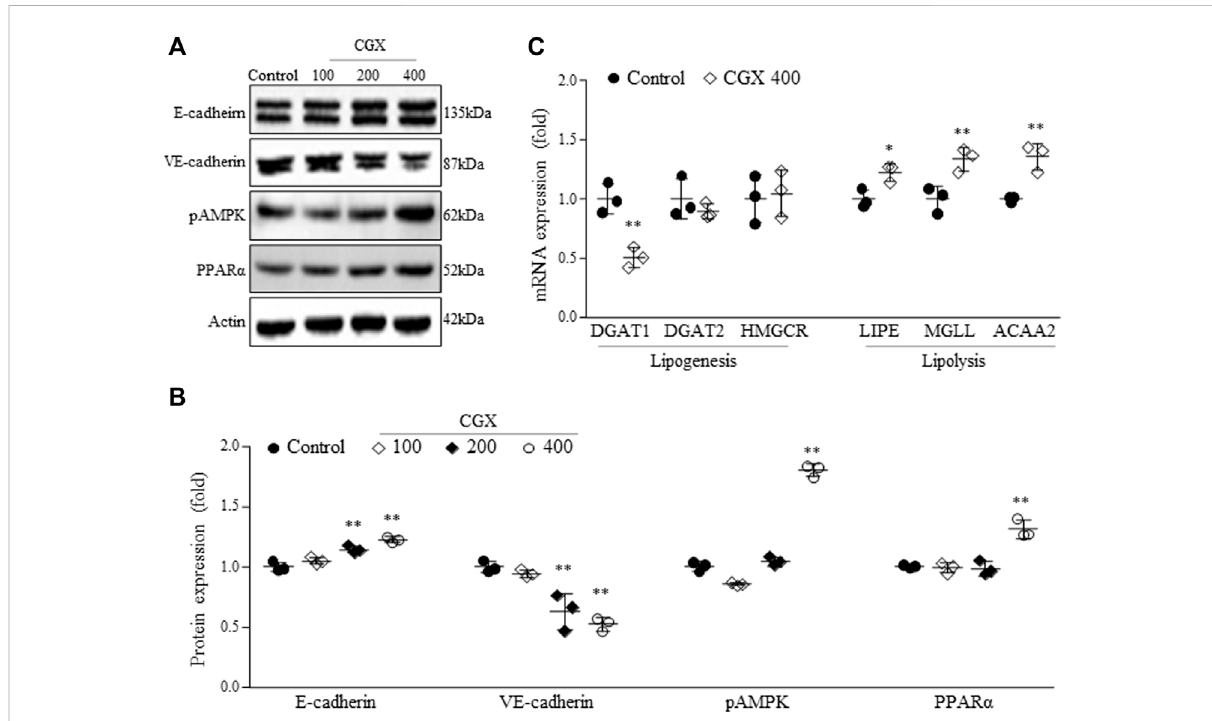
FIGURE 4 Effects of CGX on cell adhesion- and lipid metabolism-related molecules. The protein (A,B) and mRNA levels (C) were determined using westernblottingandPCR,andnormalizedto β -actin,respectively.Thedataareexpressedasthemeans±SD( n =3).* p < 0.05or** p < 0.01indicates statisticalsigni fi cancecomparedtothecontrolgroup.E-cadherin;epithelialcadherin,VE-cadherin;vascularendothelialcadherin, pAMPK;phospho adenosine monophosphate kinase, PPAR α ; peroxisome proliferator-activated receptor alpha, DGAT1 and two; diacylglycerol